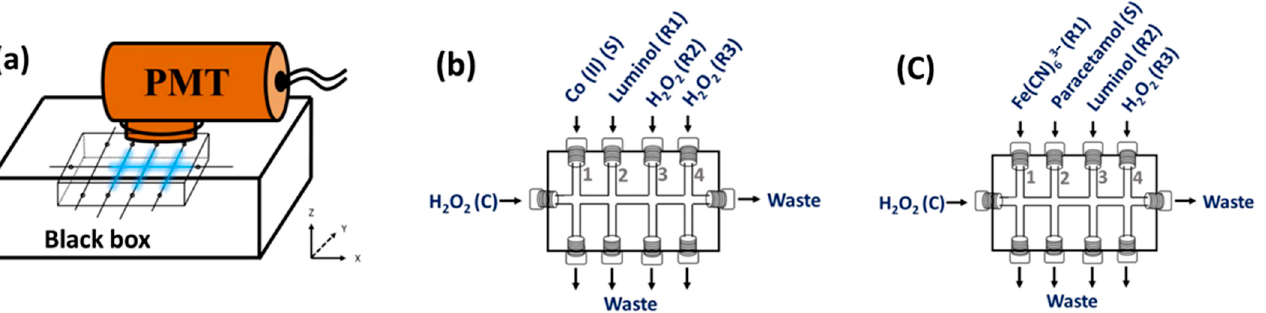
Figure 4. Schematics of the setup of the CIA platform: ( a ) area (blue zone) of collection of light by the side-on PMT, ( b ) flow arrangement for Co(II) analysis and ( c ) flow arrangement for paracetamol analysis. See Figures S1 and S3 for details of the final setup of the CIA-CL systems for Co(II) and paracetamol analyses, respectively.